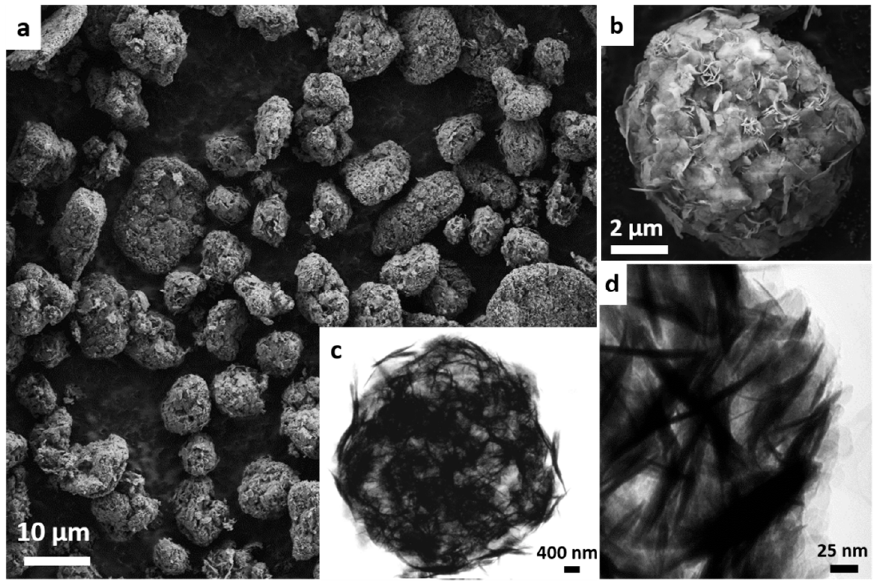
Figure 2. SEM micrographs ( a , b ) and TEM images ( c , d ) of the MWW-HT zeolitic product.